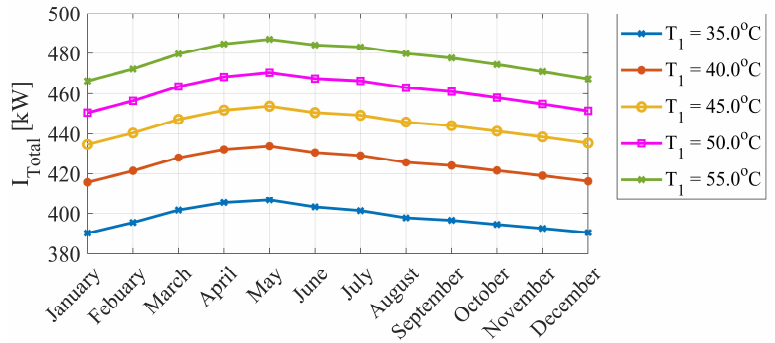
Figure 9. Total exergy destruction at different compressor inlet temperatures ( T 1 ).